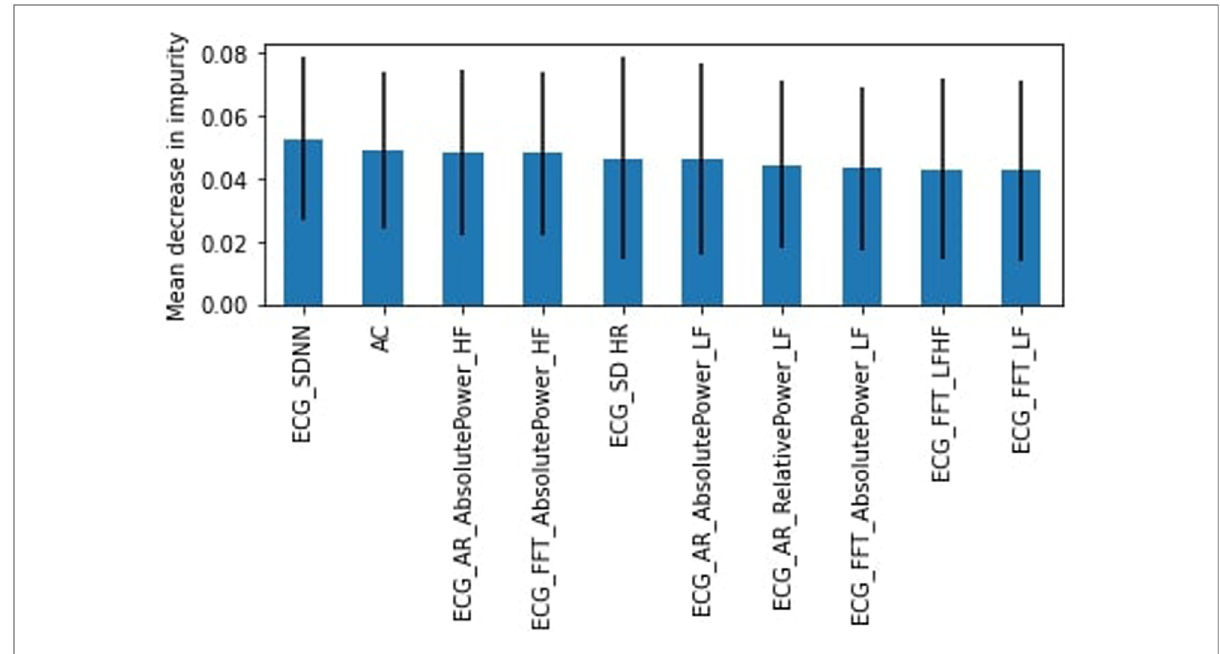
FIGURE 6 RF feature importance, subjects aged 25 – 34.